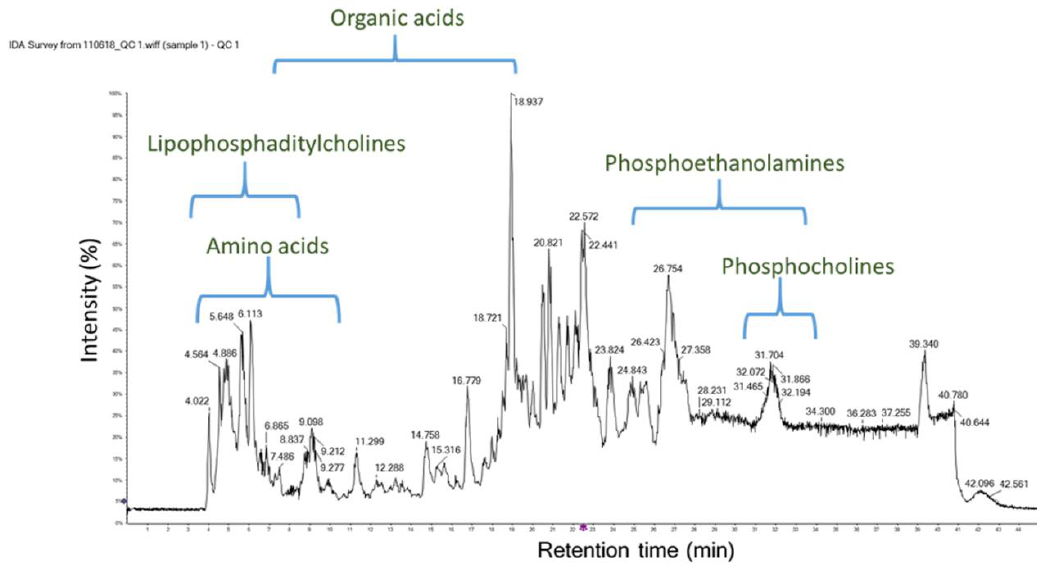
Figure 7. Reproduced from Chakrabarti, P.; Morré, J.T.; Lucas, H.M.; Maier, C.S. and Sagili, R.R. The omics approach to bee nutritional landscape. Metabolomics 2019 , 15 , 127, doi:10.1007 / s11306-019-1590-6. The figure represents a total ion chromatograph of a representative metabolomics study, highlighting a few major groups of compounds identified across various retention times.